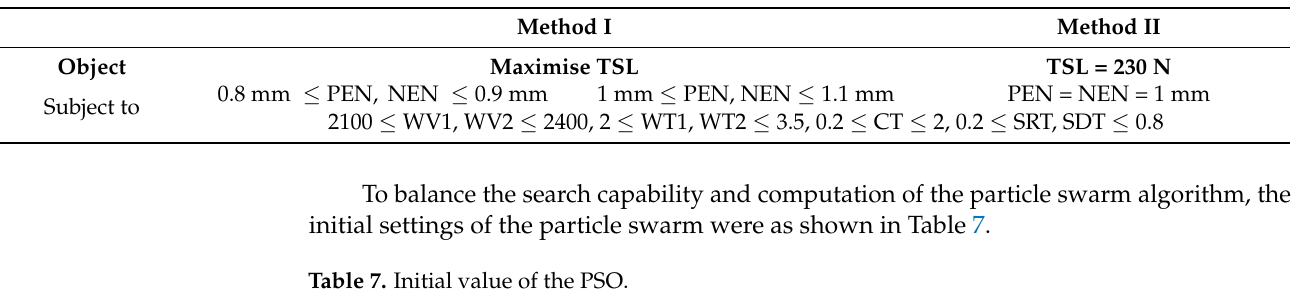
Table 6. Two optimisation methods.